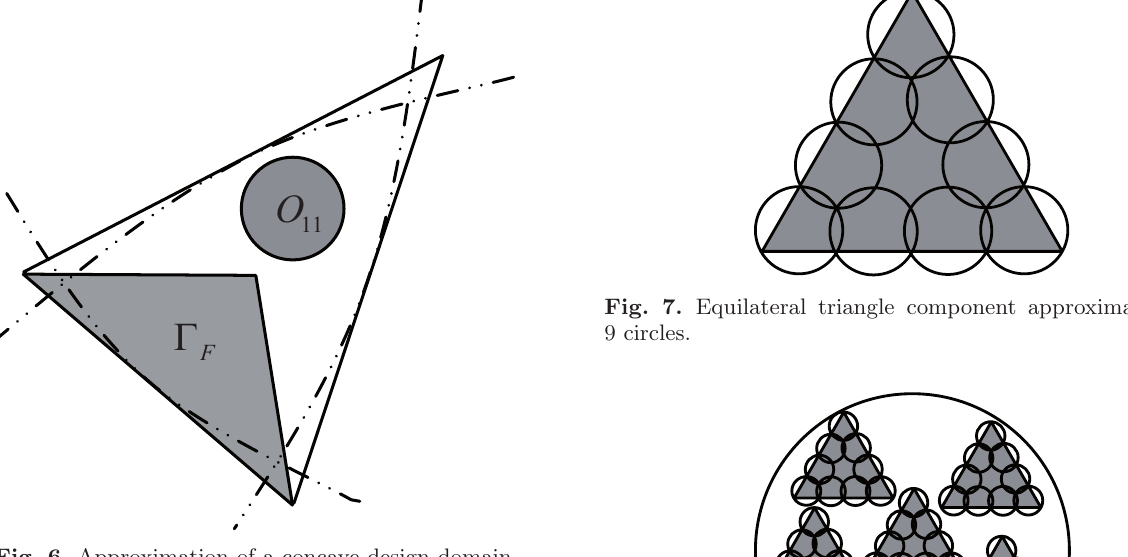
Fig. 6. Approximation of a concave design domain.